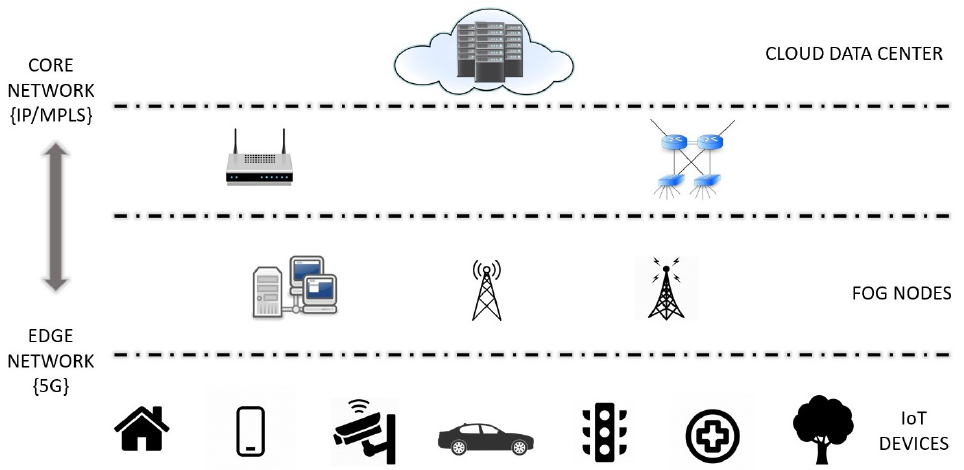
Figure 2. Hierarchical Infrastructure of the Fog